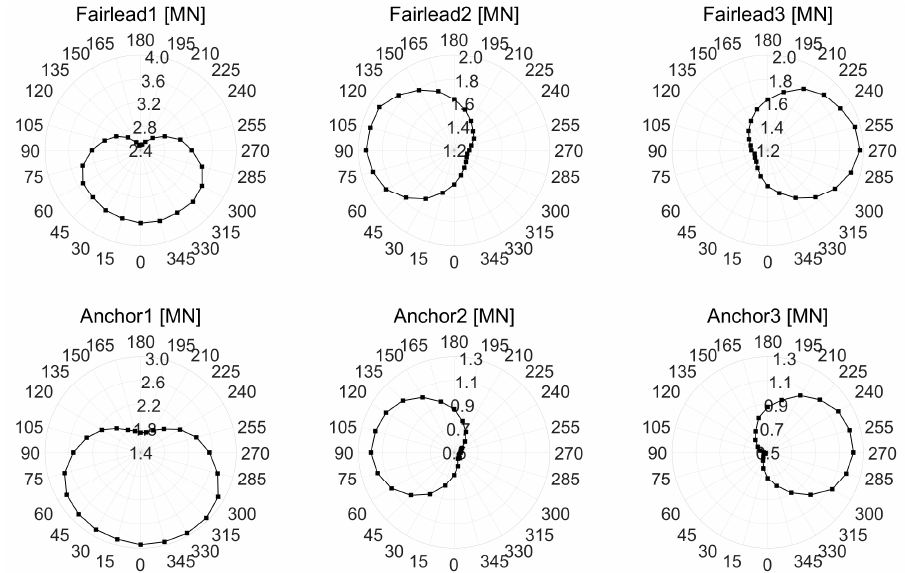
Figure 6. Absolute maximum values of the fairlead and anchor tensions according to the 24 wave directions.